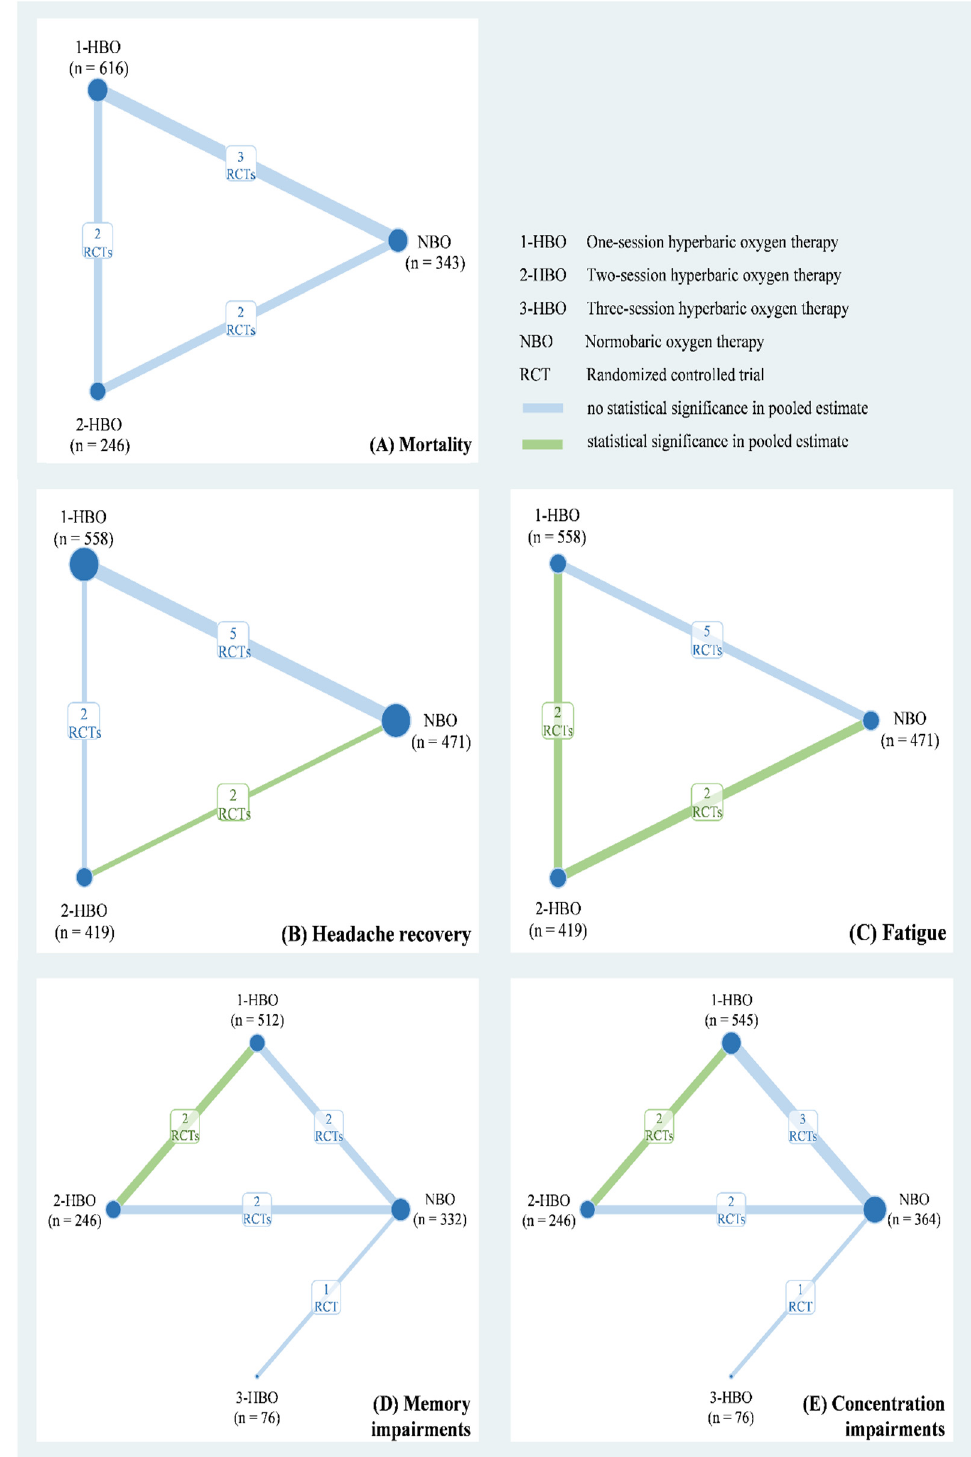
Figure 2. Network plot of hyperbaric oxygen strategies of each outcome.